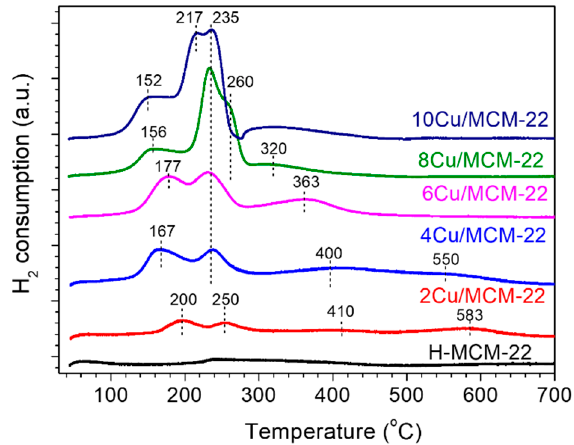
Figure 5. H 2 -TPR profiles of H-MCM-22 and x Cu/MCM-22 zeolites.